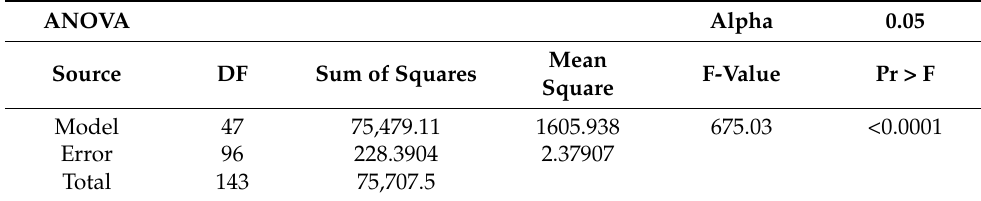
Table 3. ANOVA table for moisture content.